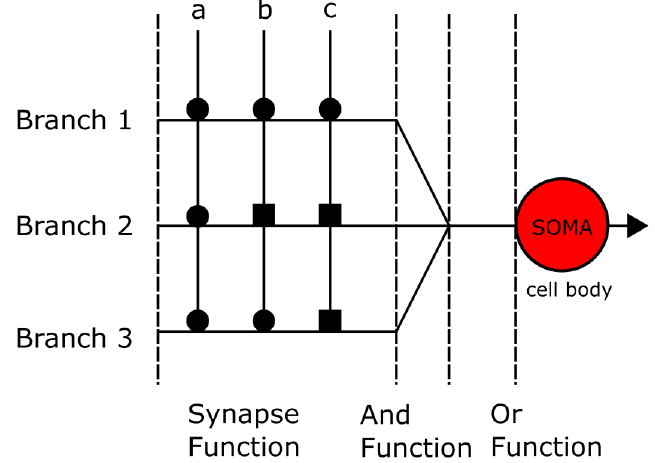
Figure 3. The structure of the Dendritic Neuron Model with several branches and a soma. The input signals are a, b, and c, respectively, which are received by the synapses on branches numbered 1, 2, and 3, and the received signals are labeled as a1, b1, c1,